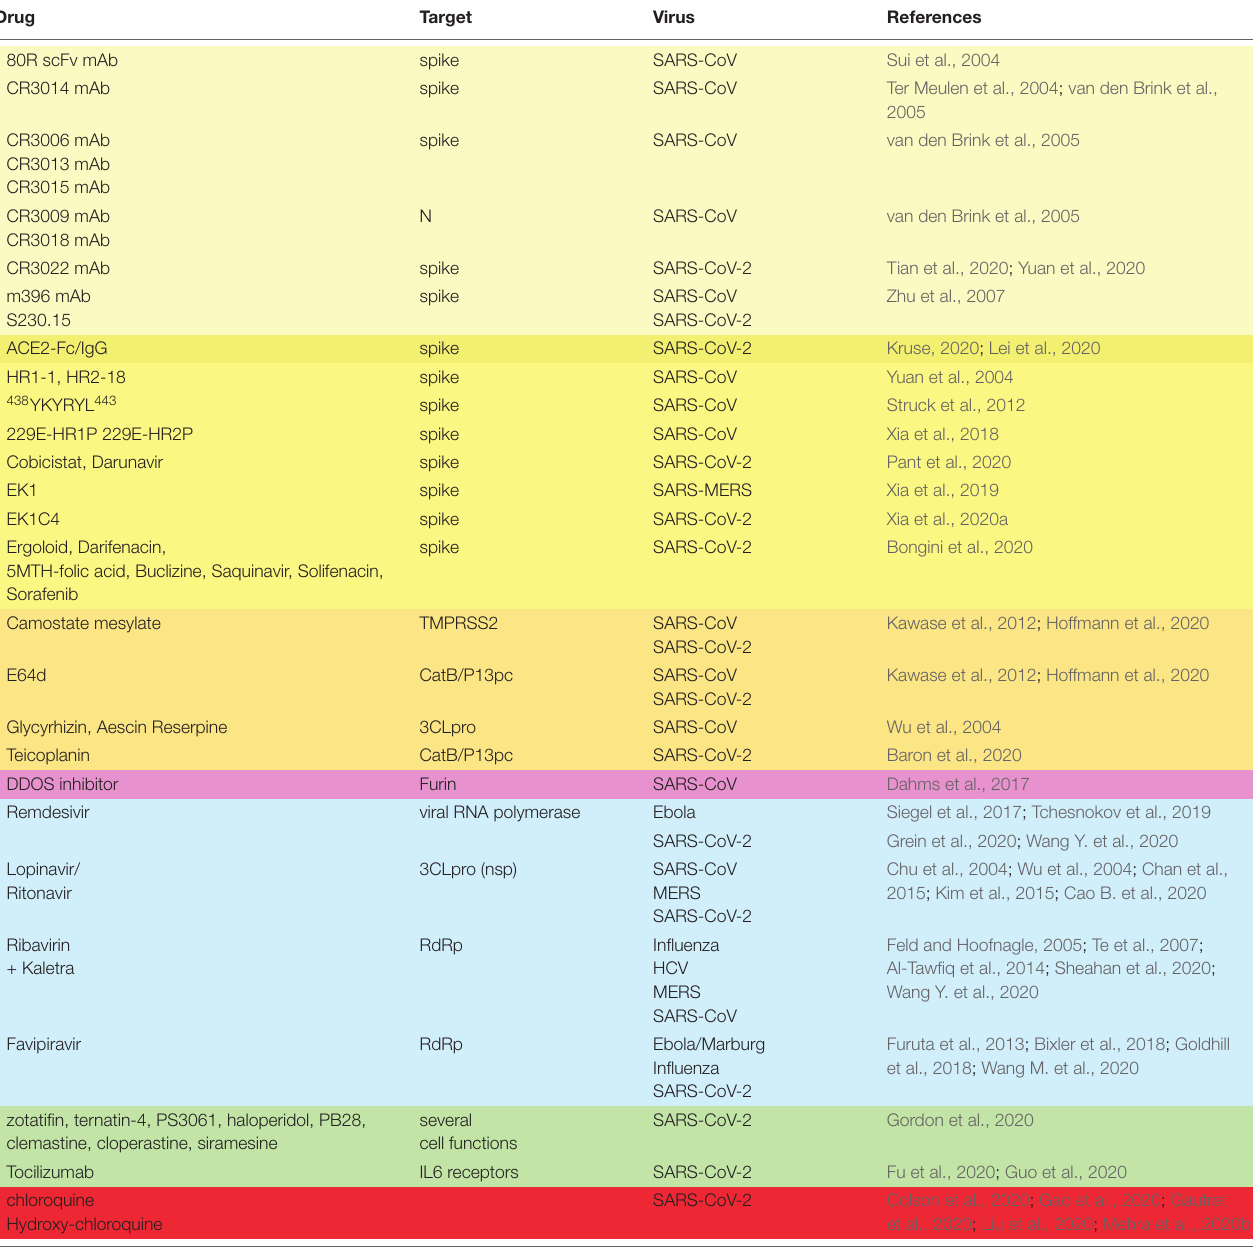
TABLE 3 | Drugs proposed for the treatment of SARS-CoV-2 infected patients.